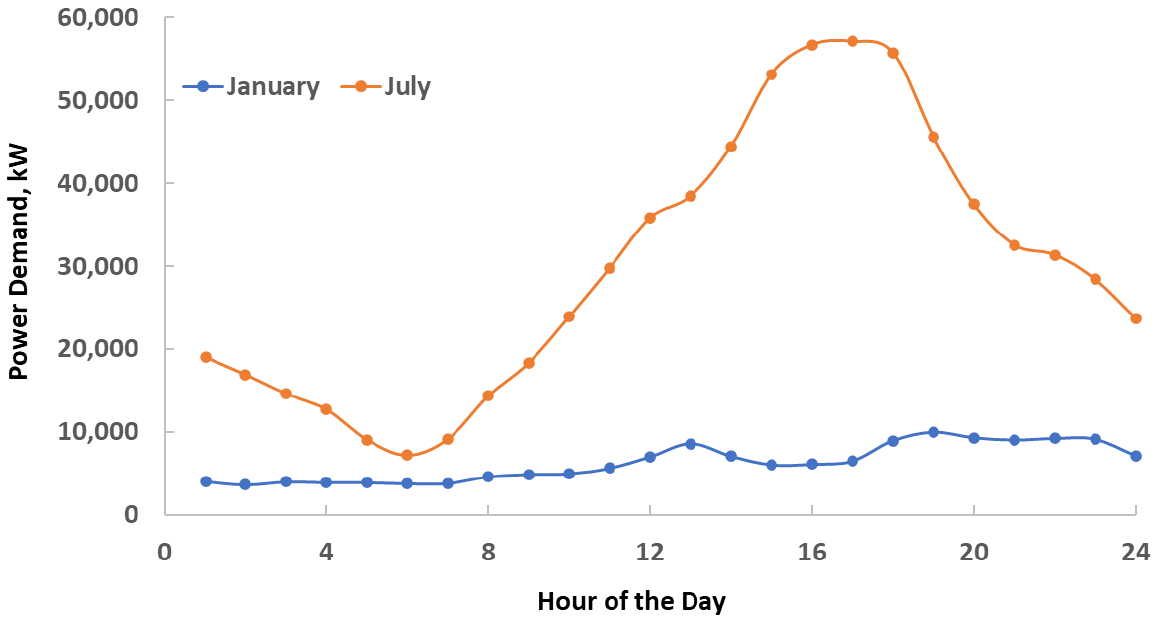
Figure 1. Typical electric power demand of the community during days in January and July. It is axiomatic that the electric power demand of the simulated community must be matched by the supply, which is derived from photovoltaic (PV) systems and wind turbines. Since the two RES are not dispatchable, energy storage systems are also needed to supply the community during the hours of low electric power generation. The schematic diagram of the proposed electric power system is shown in Figure 2, where the arrows denote the flow of electric power. Electricity is generated by an array of wind turbines and several solar farms with PV cells. Given the generated noise, the wind turbines may not be located very close to the community, but rather within a radius of 150 km. The performance of the PV systems is enhanced by maximum power point trackers (MPPT) and controllers ensure the optimum generation of solar power. Since the homes use alternating current (ac), voltage inverters convert the direct current (dc) generated in the PV cells—as well as in the fuel cells –to alternating current (ac). The instantaneously generated electric power is fed to the buildings to supply all or part of the hourly demand. When the generated power is